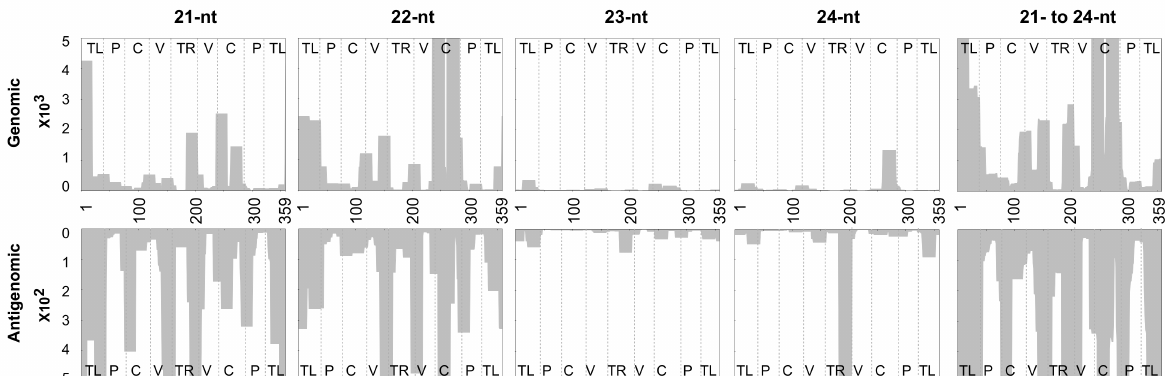
Figure 3. Profiling of the vd-sRNAs recovered from PSTVd-I-infected tomato plants at one mismatch. Sequence profiles of the (+) and the ( − ) PSTVd-sRNA populations recovered from the leaf tissues of infected tomato plants. The data were normalized to reads per million. In the figure, different structural regions of PSTVd are delimited by dashed lines (from left to right, TL, terminal left; P, pathogenicity; C, central; V, variable; and TR, terminal right).